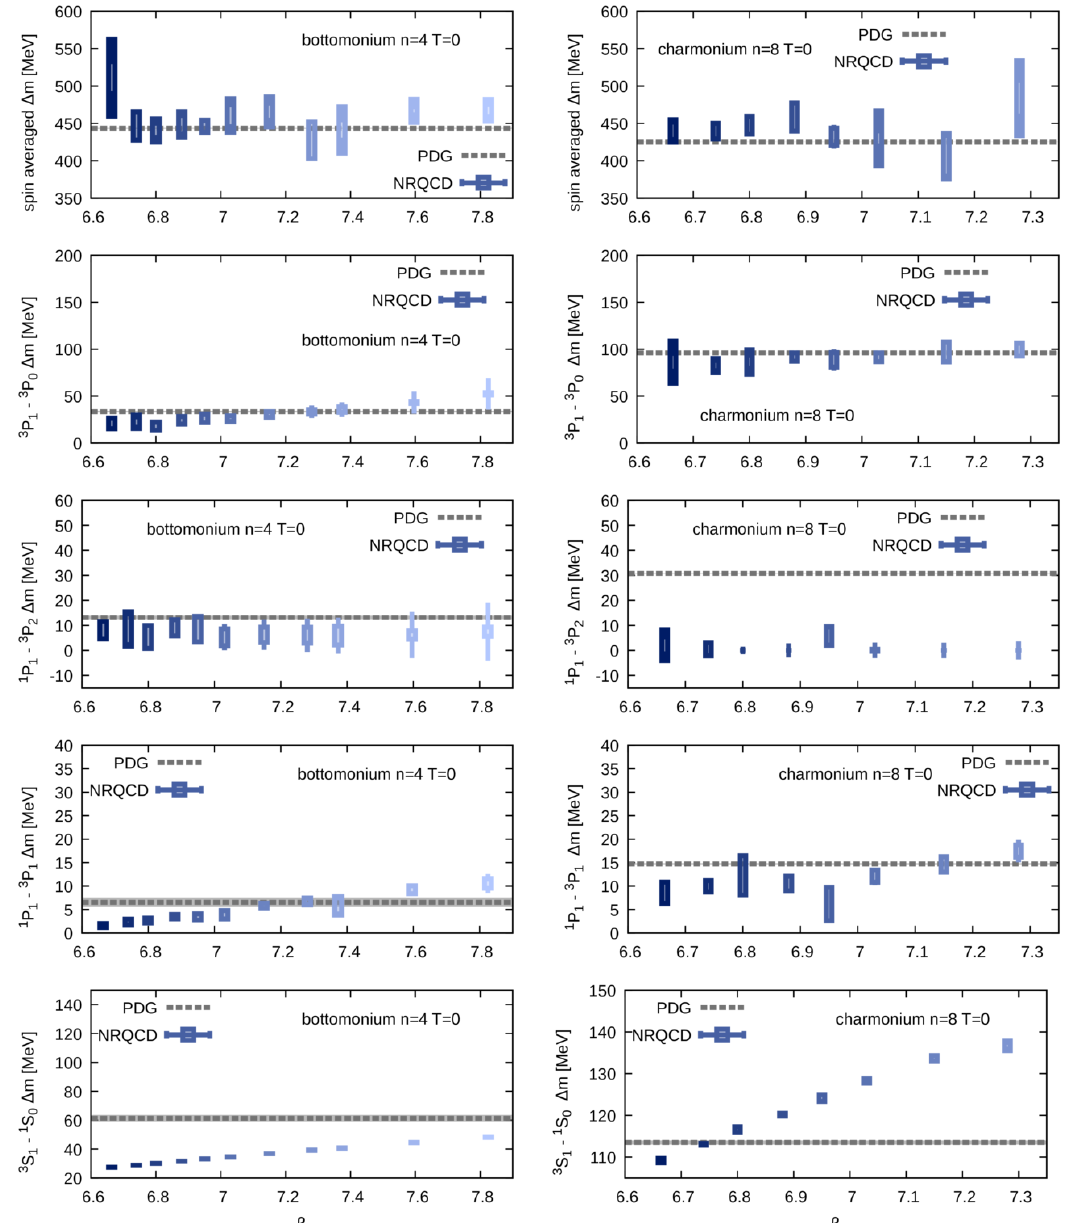
Figure 6 . Quantitative test of our NRQCD simulation setting with bottomonium results on the left and charmonium on the right.(top) The mass splitting between the three spin weighted 3 P 0 ; 1 ; 2 states and the spin weighted 1 S 0 and 3 S 1 ground states. (second from top) The inter-triplet spacing between the scalar and vector states 3 P 0 and 3 P 1 . (center) The spacing between the 1 P 1 and the tensor states 3 P 2 . (second from bottom) The hyper(cid:12)ne structure between the P-wave 1 P 1 and 3 P 1 ground states. (bottom)The S-wave hyper(cid:12)ne splitting between the ground states of the 3 S 1 and 1 S 0 channel.